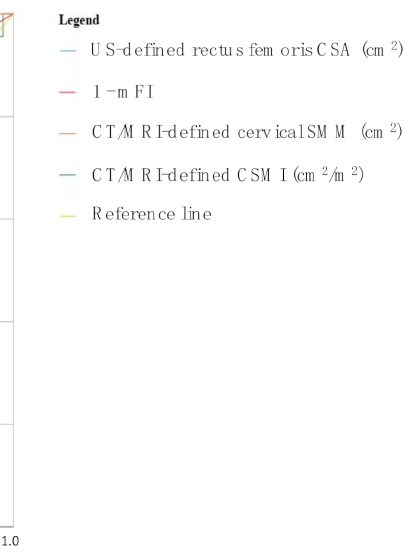
Figure 4. Box-plots depicting ultrasonographically-defined rectus femoris cross sectional area (upper left, cm 2 ), CT/MRI-defined cervical skeletal muscle mass (upper right, cm 2 ) and CT/MRI-defind cervical skeletal muscle index (lower, cm 2 /m 2 ) as stratified by the occurrence of 30-day major postoperative complications; CSA: cross sectional area; SMM: skeletal muscle mass; CSMI: cervical skeletal muscle index.